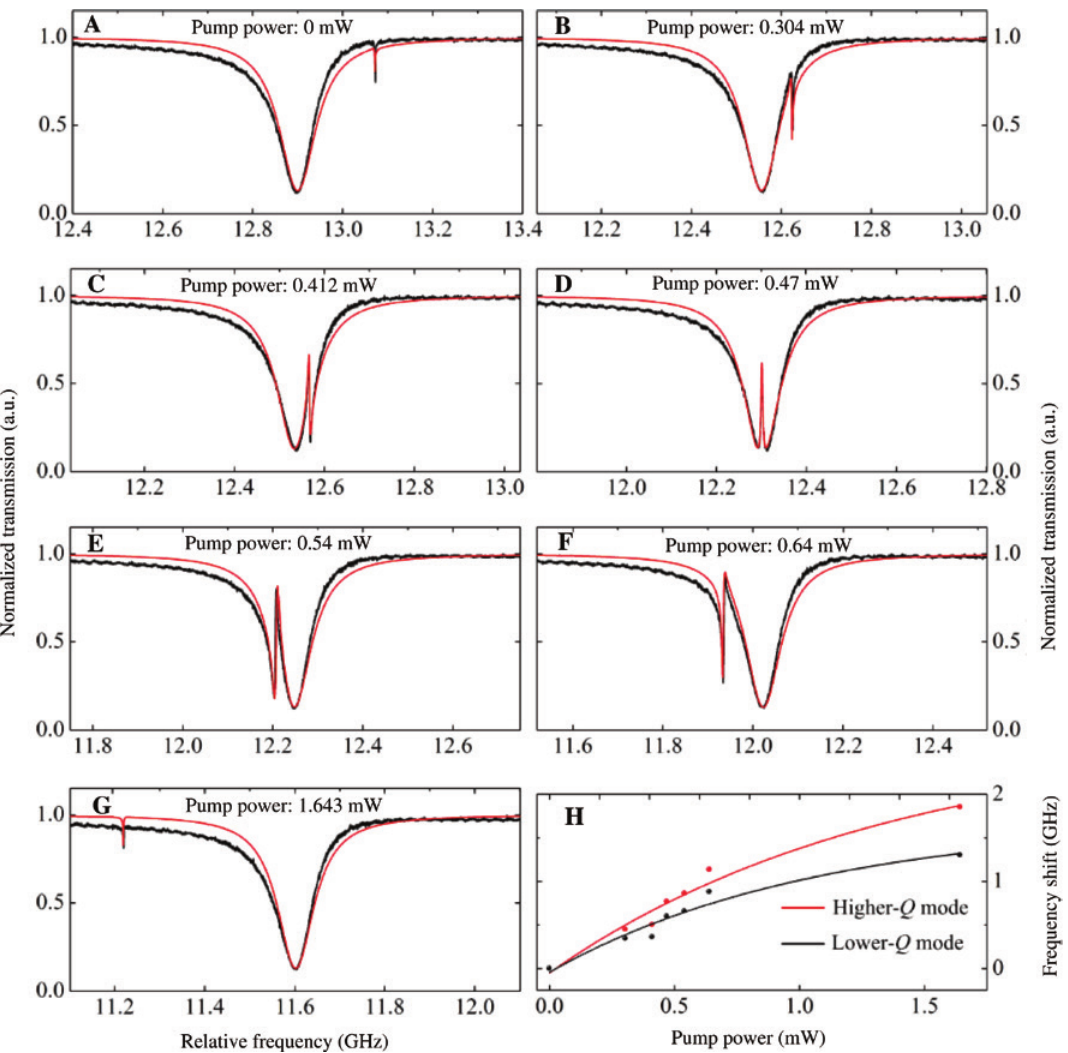
Figure 6: Transmission spectra for different frequency detunings between the coupled WGMs. (A–G) Measured EIT spectra (black lines) of the coupled microcavities for different pump powers. Frequency detunings are 171.07, 65.89, 30.36, 0, −33, −83.61, and −381.02 MHz, respectively. (H) Frequency shifs of the higher- Q and the lower- Q modes as a function of the pump